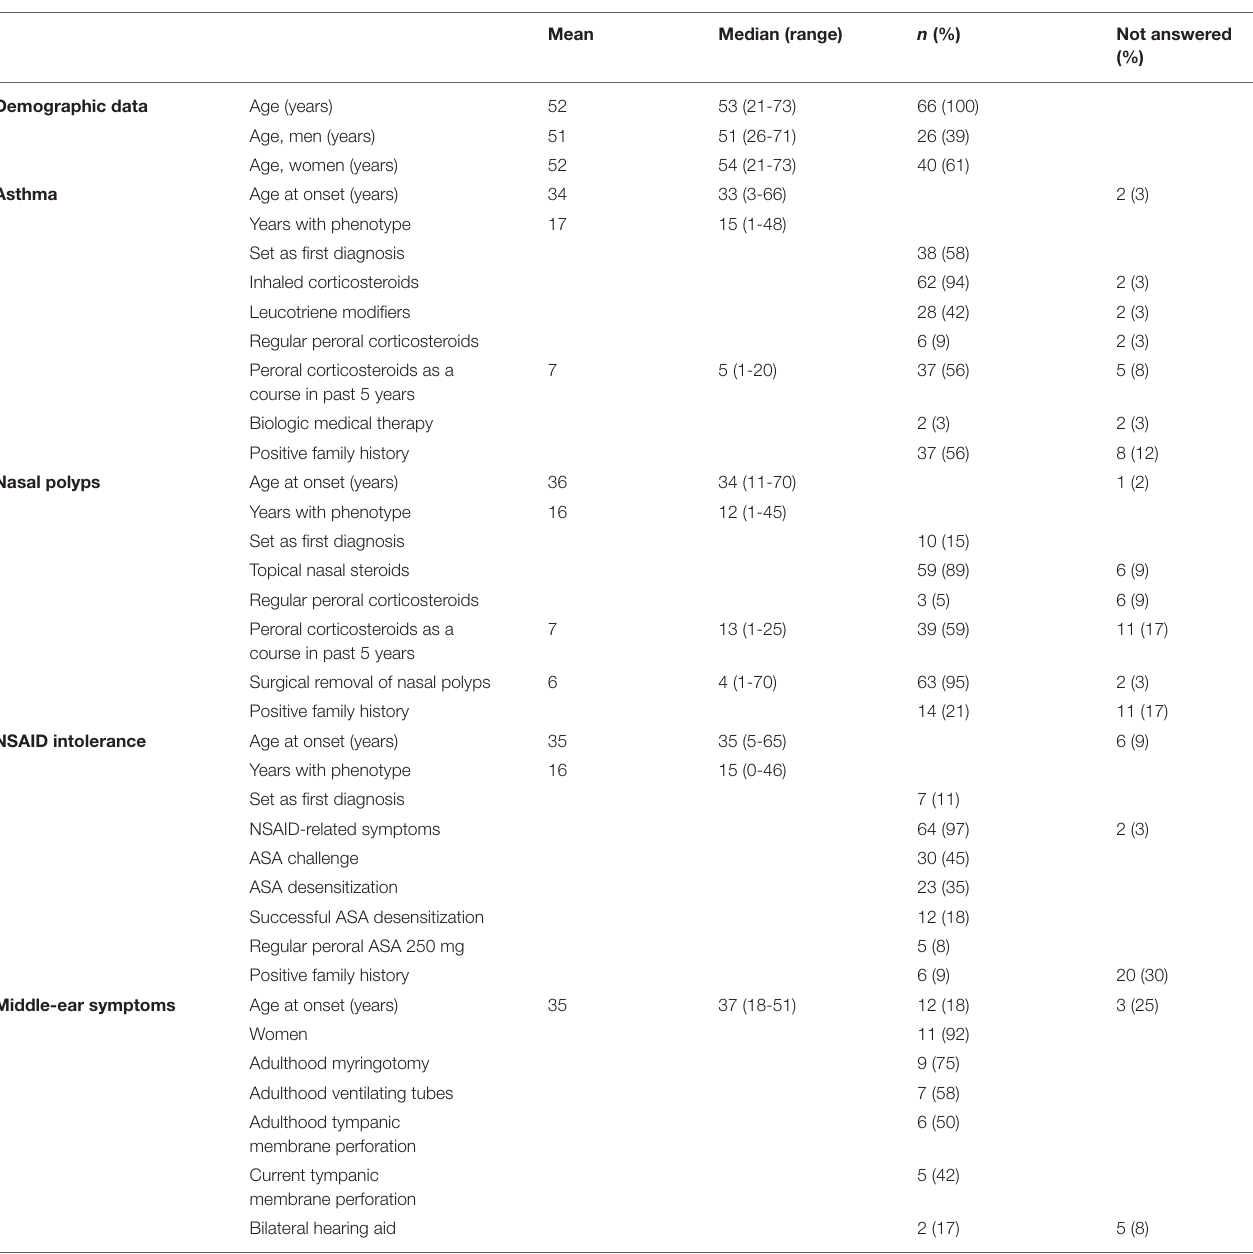
TABLE 1 | Demographic and clinical characteristics of 66 included